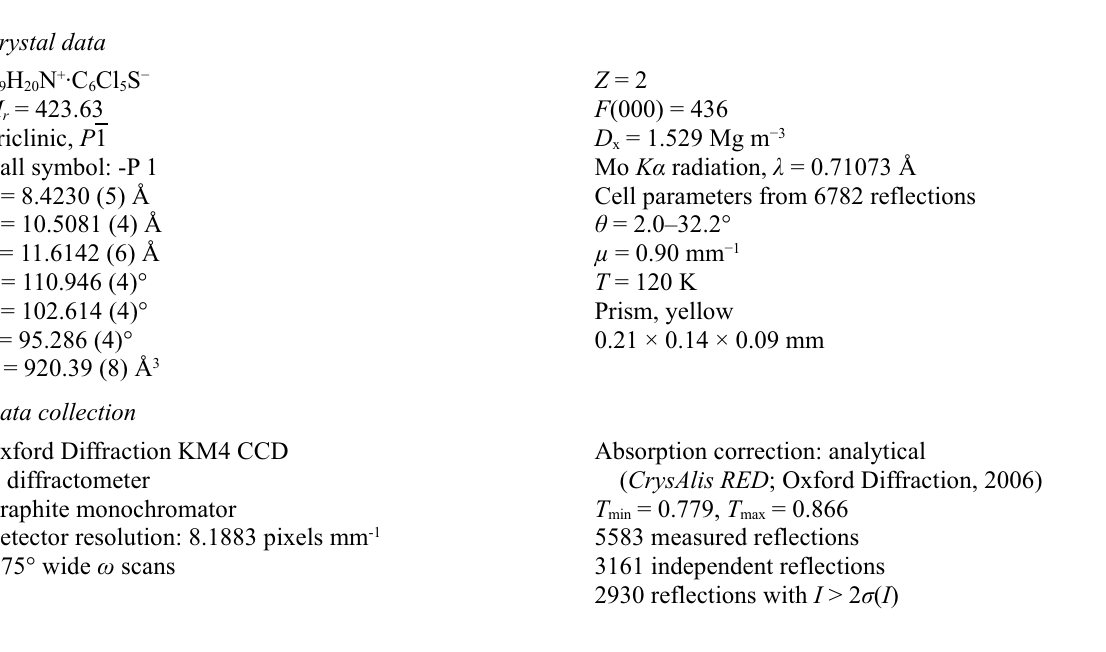
The crystal packing of (I), viewed approximately down the a axis. 2,2,6,6-Tetramethylpiperidinium